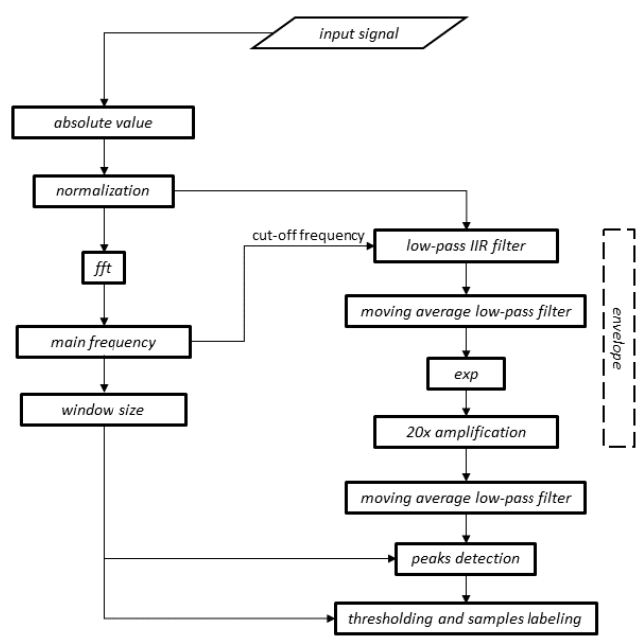
Figure 2. Diagram of the developed method of TMJ acoustic signal segmentation. The cut-off frequency of the low-pass filter is automatically calculated for each signal and is equal to its main frequency.